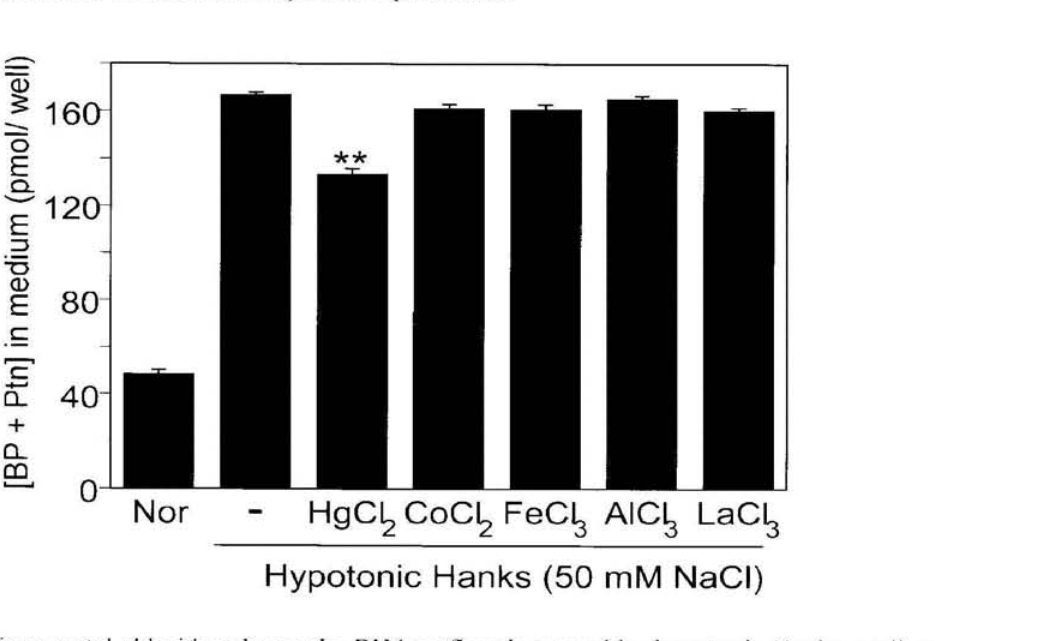
Figure 2B. Effect of various metal chloride salts on the BH4 outflow increased by hypotonic Hanks medium. PC 1 2 cells were incubated in normal Hanks medium (138mM NaCl) and hypotonic Hanks medium (50 mM NaCl) in the presence of various metal chloridc salts (20 μΜ each) for 10 min in a CO, incubator at 37°C. Values are the means ± SD (n=4). **p<0.001 vs. the value obtained with the hypotonic Hanks medium.